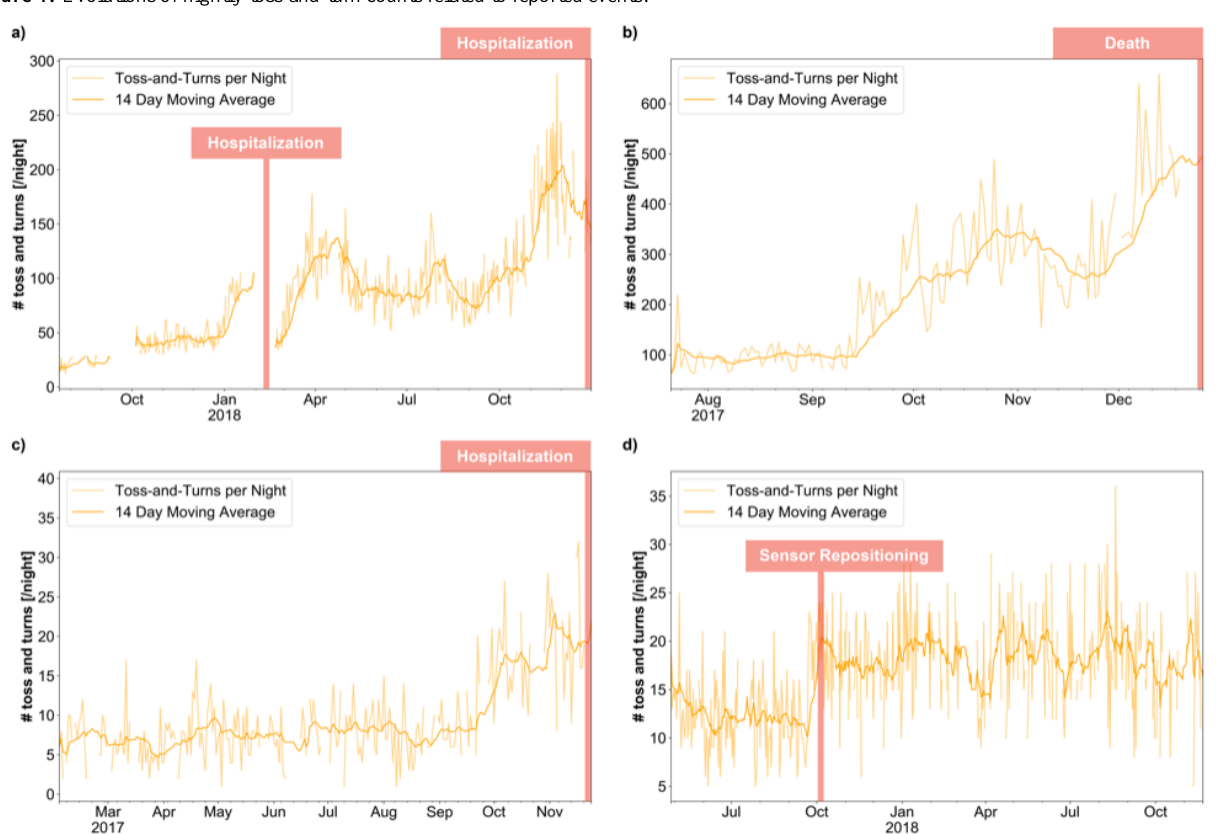
Figure 4. Evolutions of nightly toss-and-turn counts related to reported